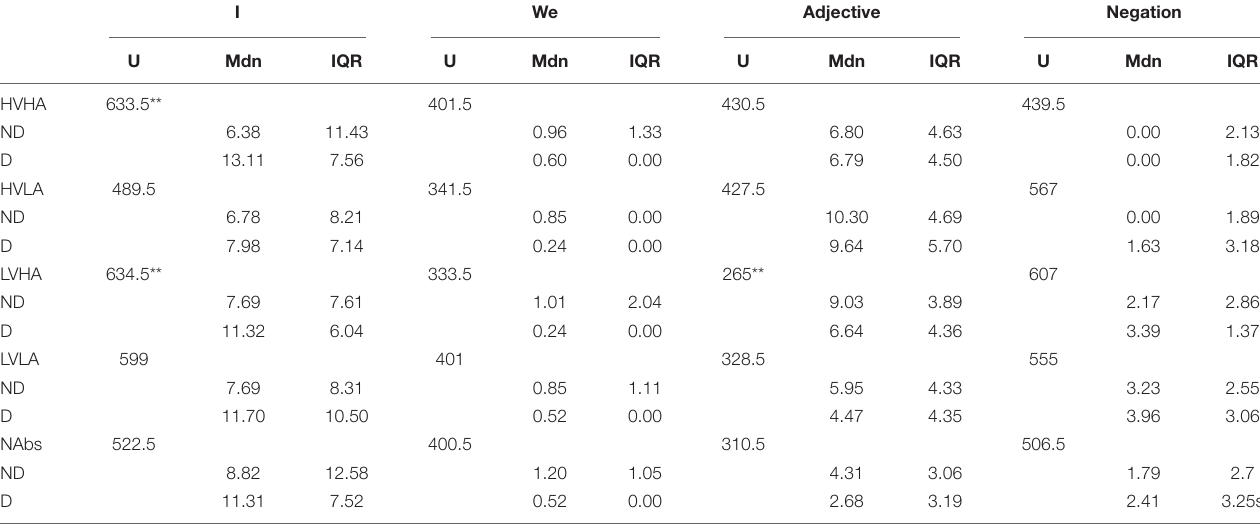
TABLE 7 | LIWC percentages of linguistic variables for stimuli